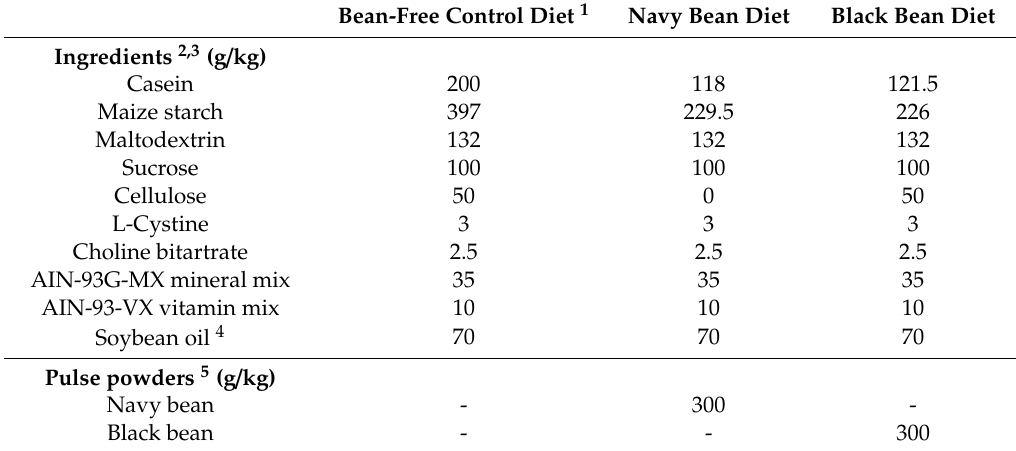
Table 1. Experimental diet